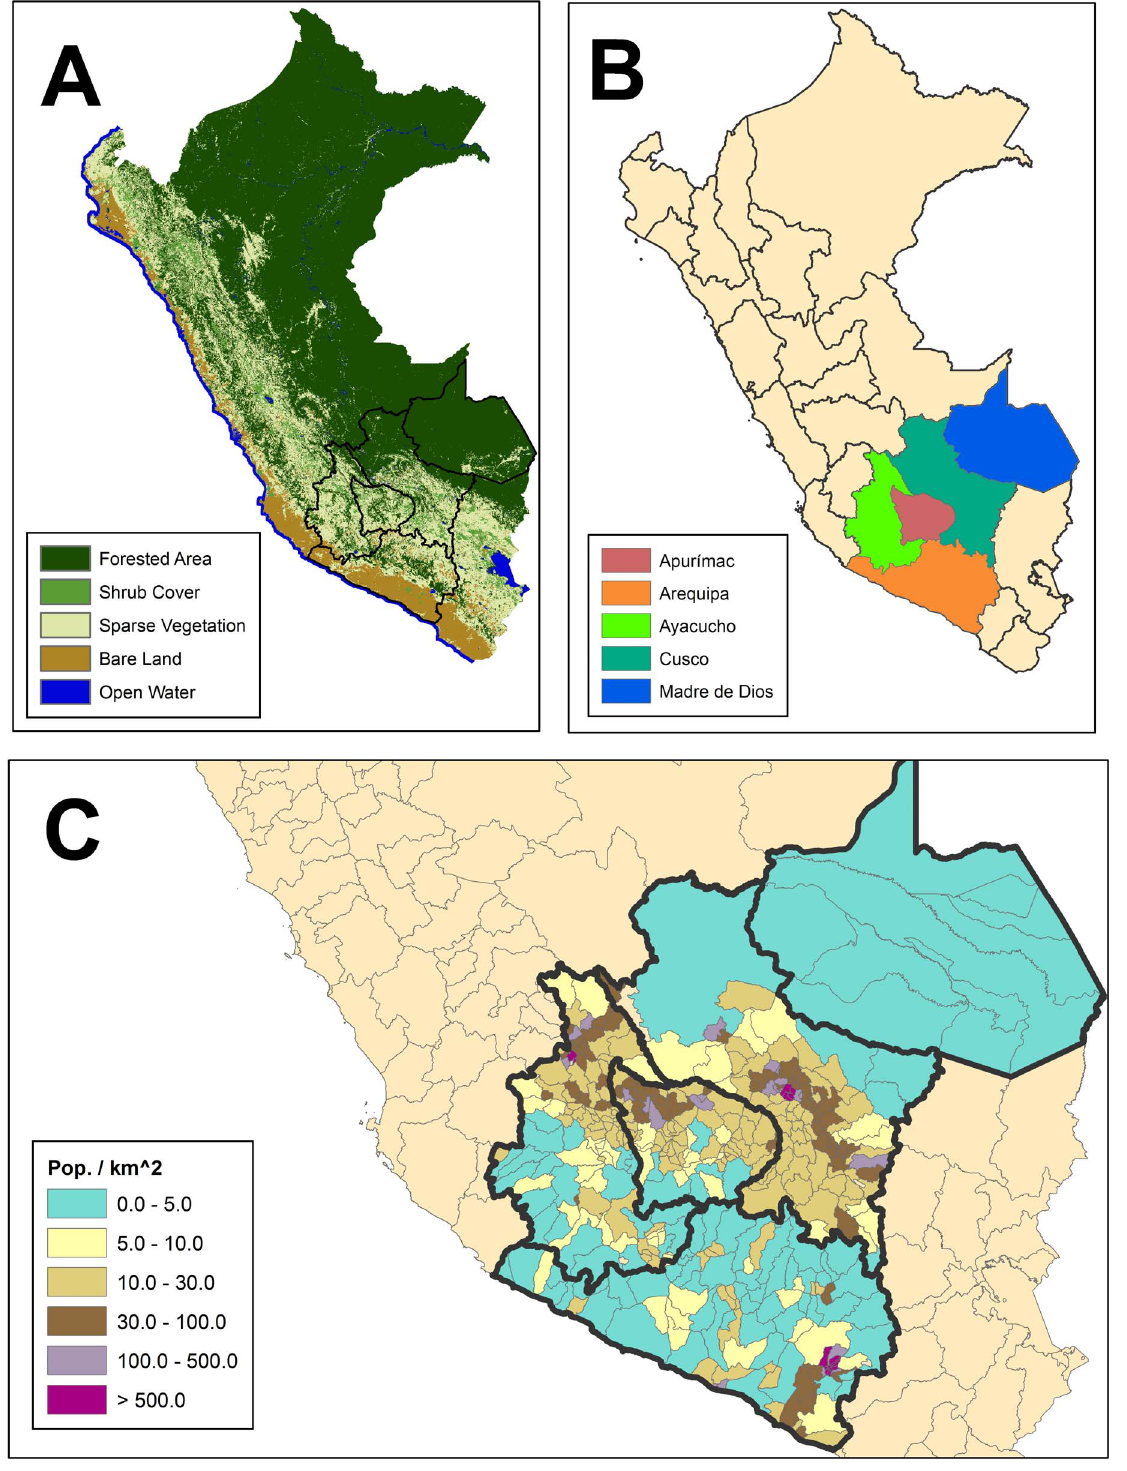
Figure 2. Political boundaries and topographical features of Peru. A) Classified land cover. B) Regions included in the analysis (Apurimac, Arequipa, Ayacucho, Cusco and Madre de Dios). C) Population density at the district level derived from the 2007 census. doi:10.1371/journal.pone.0100037.g002 tree-based models were chosen to explore how predictive accuracy include a linear model (LM), linear mixed model (LMM), a and variable importance changes in the presence or absence of generalized additive model (GAM), and a multivariate adaptive population information. The regression-based model structures regression spline (MARS) structure. The tree-based models